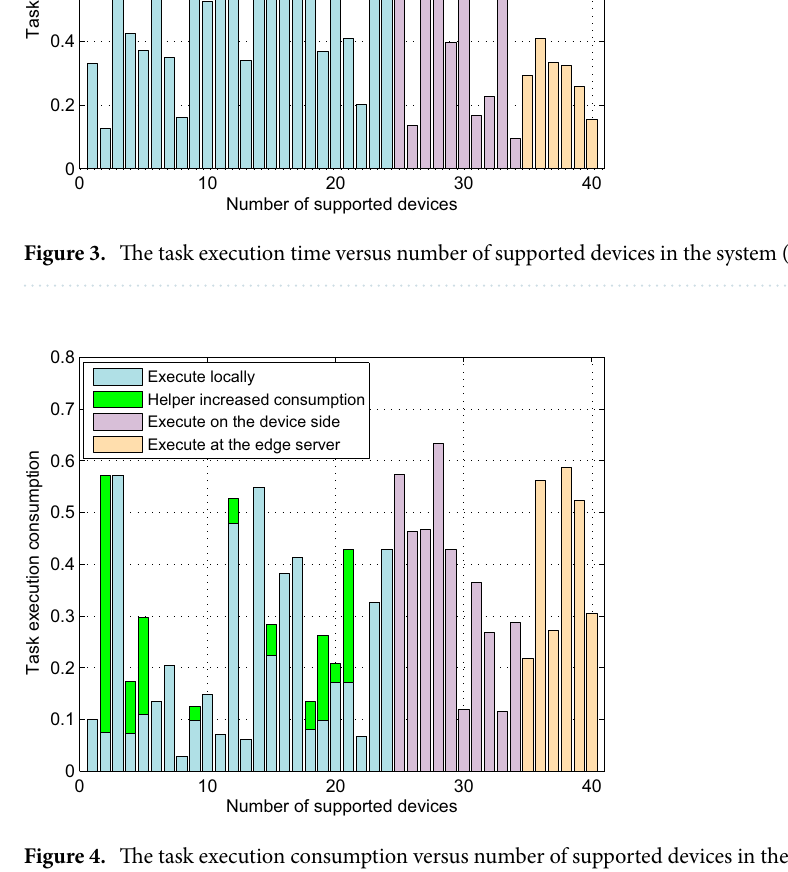
Figure 4. The task execution consumption versus number of supported devices in the system (N =